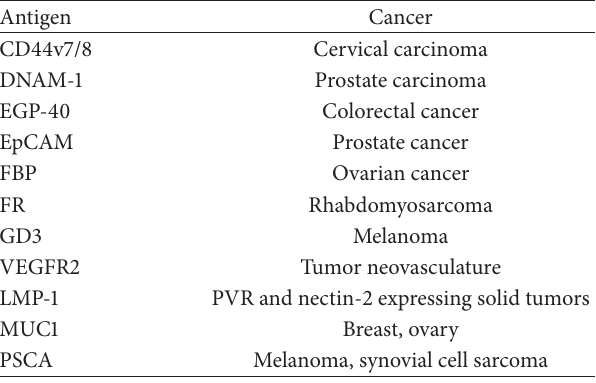
Table 2: Potential solid tumor targets for CART cell-based